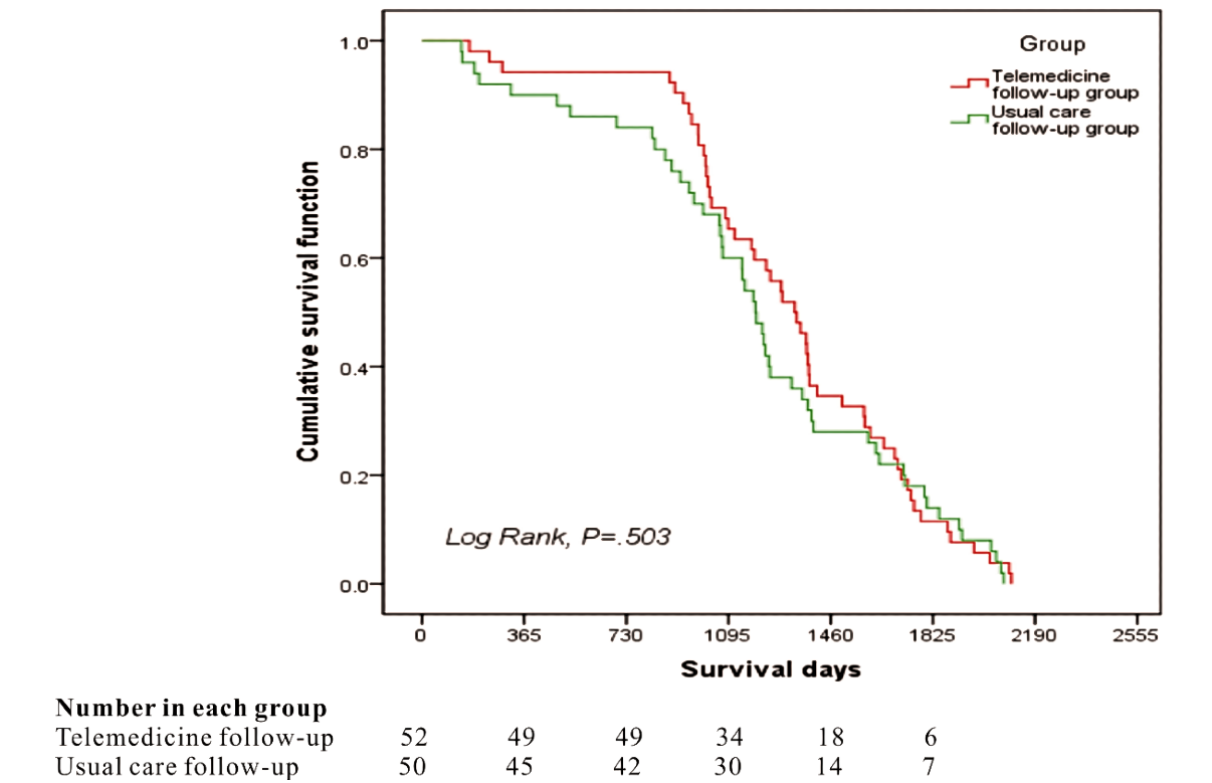
Figure 4. The cumulative survival curves for both groups in the long-term follow-up. No significant difference was detected in the cumulative survival rate between the two groups ( P